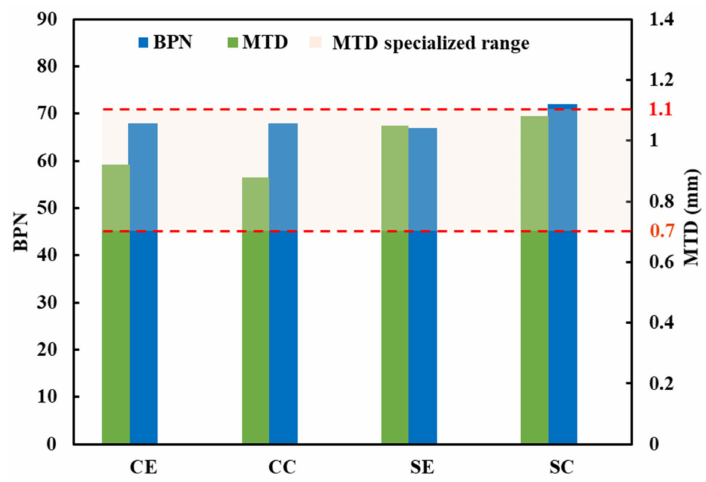
Figure 10. The results of BPN value and MTD.